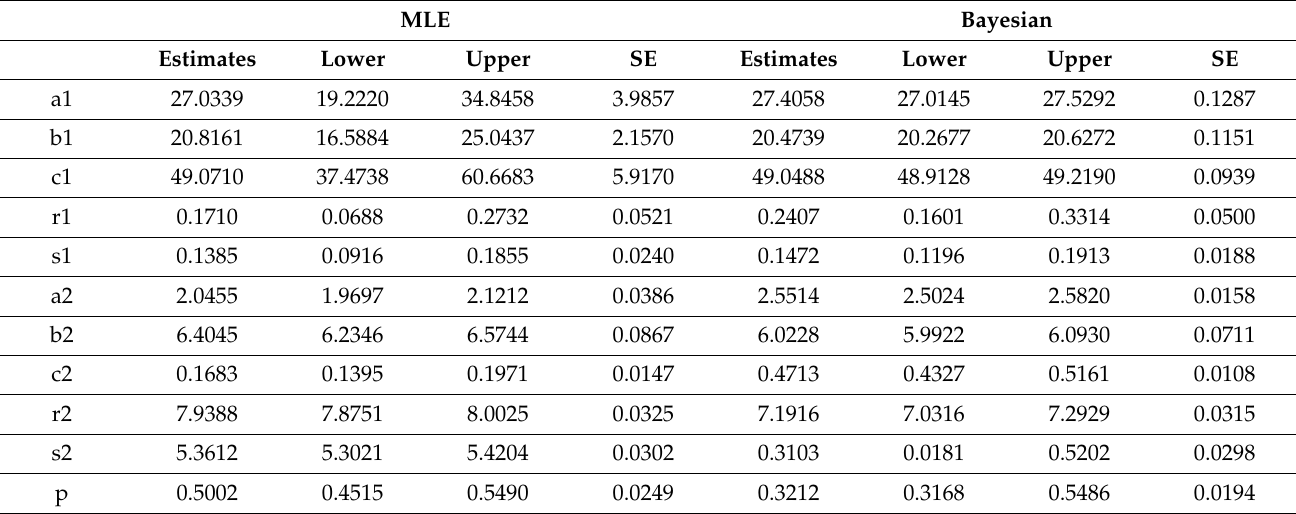
Table 13. MLE and the Bayesian estimates for the fitted MEKGEF model for the Australian ath- letes data.